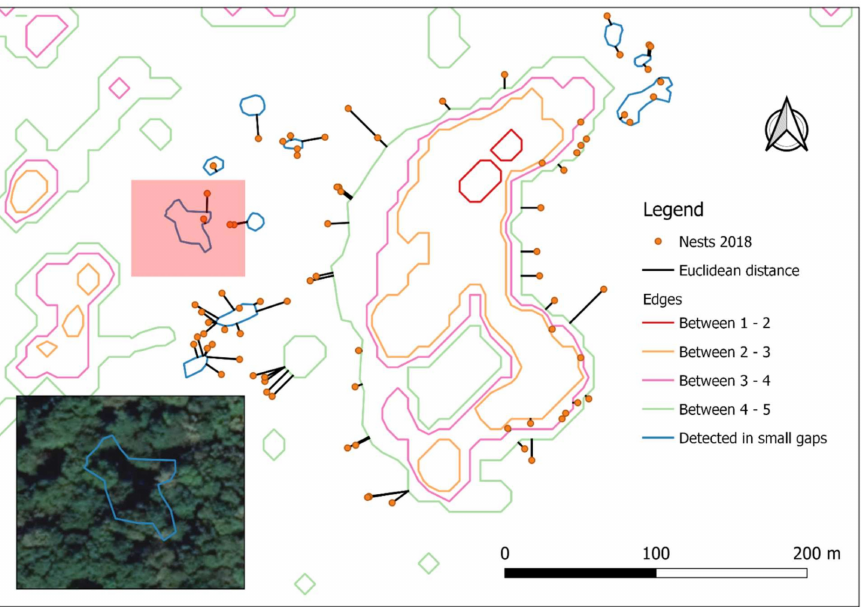
Figure 6. Mapping of the edges between NDVI categories (1 = open area, far away from edge; 2 = shaded open area near edge, outside the stand; 3 = the edge of the forest; 4 = well-lit area near edge, inside the stand; 5 = closed, dense canopy, inside stand, far from edges), nest locations, and distances to the nearest edge of a suitable habitat (categories 2–4). Blue lines describe edges of the small gaps identified later on the Google Earth high-resolution satellite image and manually added to the layer before final analysis (Photo in lower left: detail with gap not identified on the NDVI but evident on Google